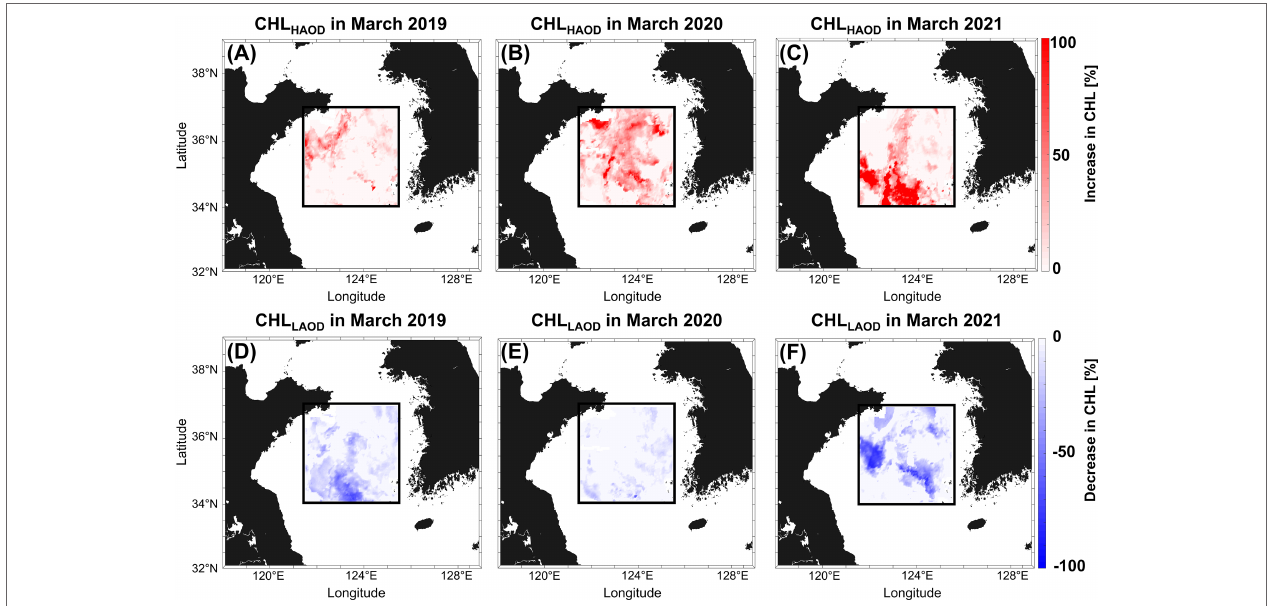
FIGURE 5 | Result of CHL RF according to changes in AOD. The upper panels (A–C) represent the result of CHL RF when AOD is increased by two sigma (2 σ , increasing about 95%) and the lower panels (D–F) show when AOD is reduced by two sigma (2 σ ,increasing about 95%) for a given